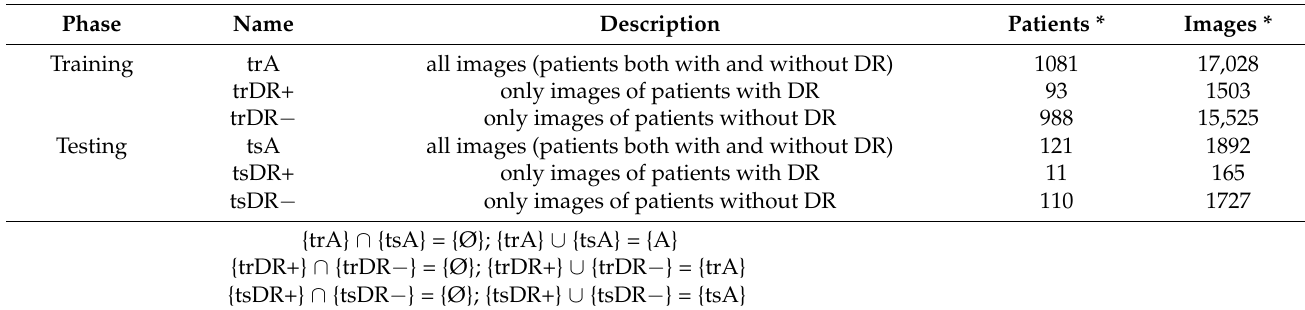
Table 1. Definition of the datasets used for training and